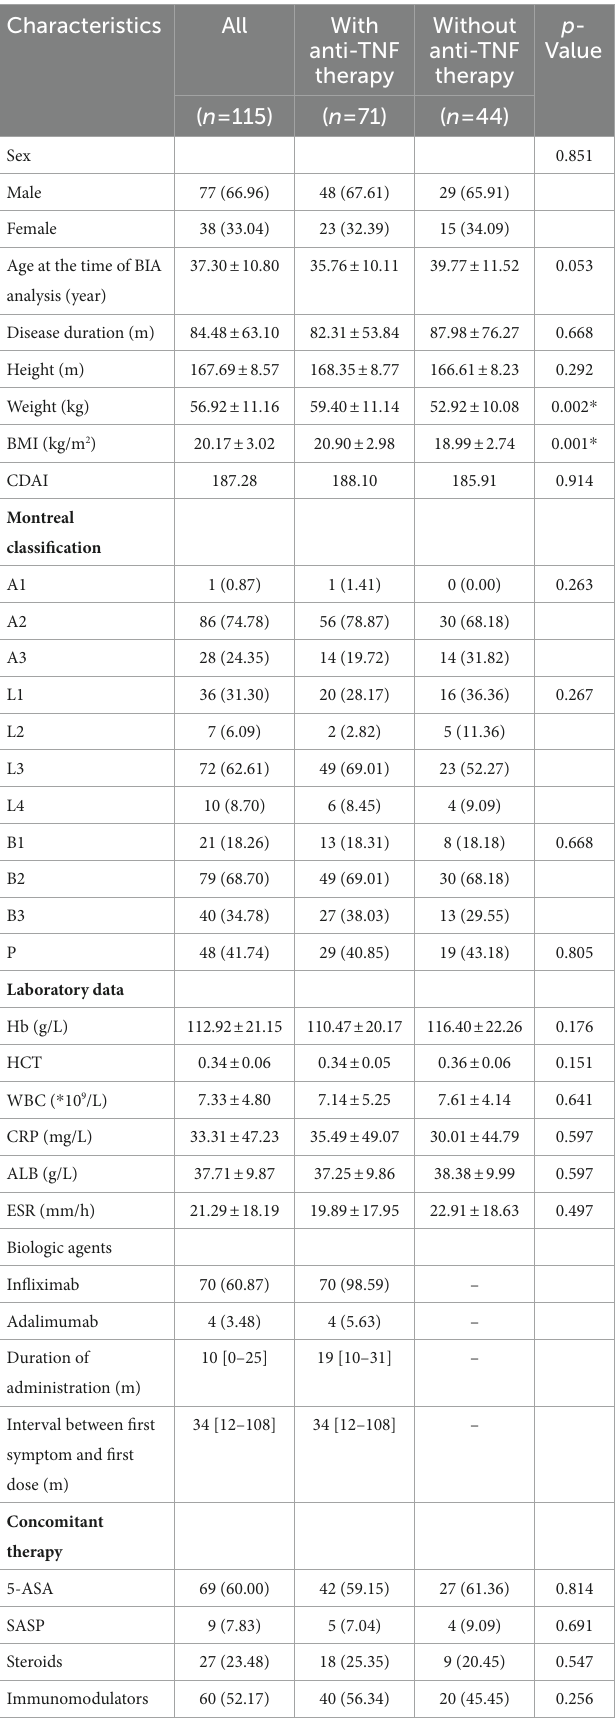
TABLE 1 Baseline characteristics of 115 CD patients enrolled. Characteristics